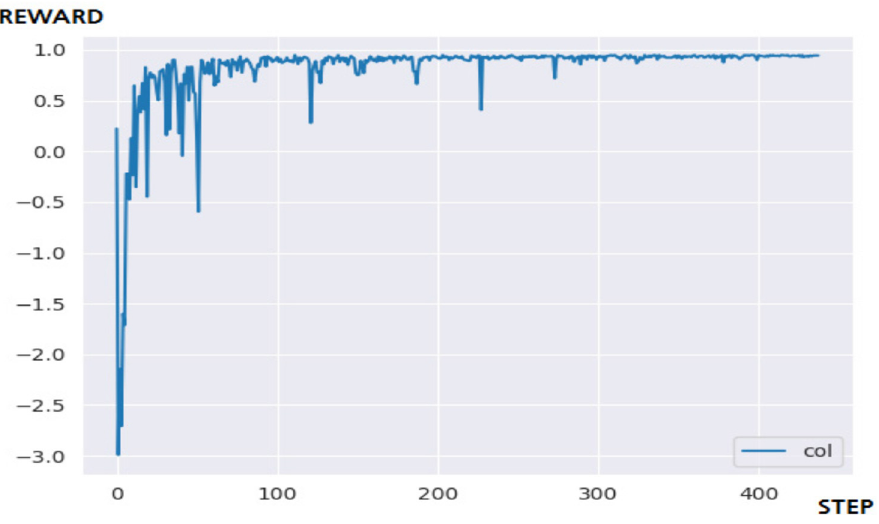
Figure 10. The result of 5 × 5 maze game through N-DQN. Table 4. Summary of 5 × 5 learning results.